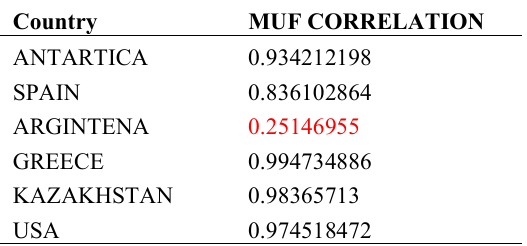
Shows the correlation between REC533 &